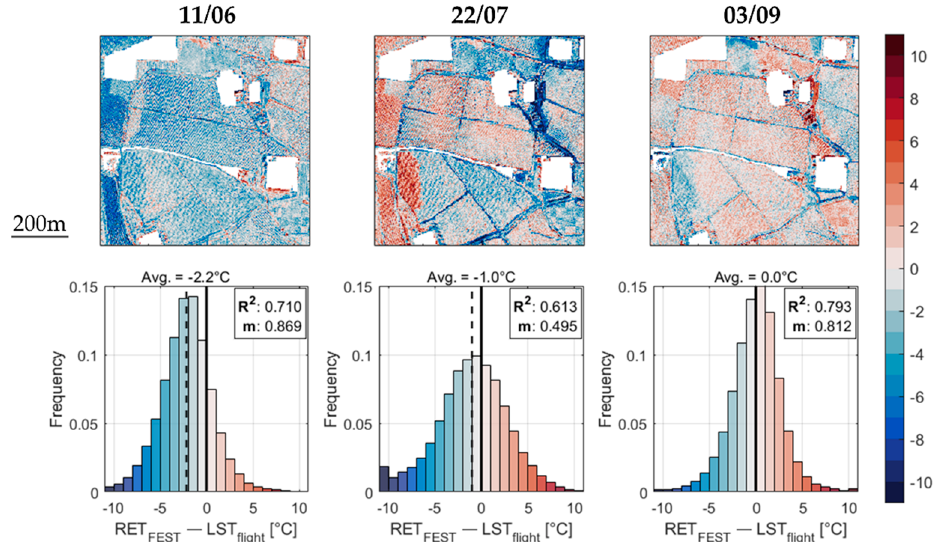
Figure 4. Temperature differences (RET–LST) for the three calibration dates: spatial distributions (upper row) and histograms (lower row).